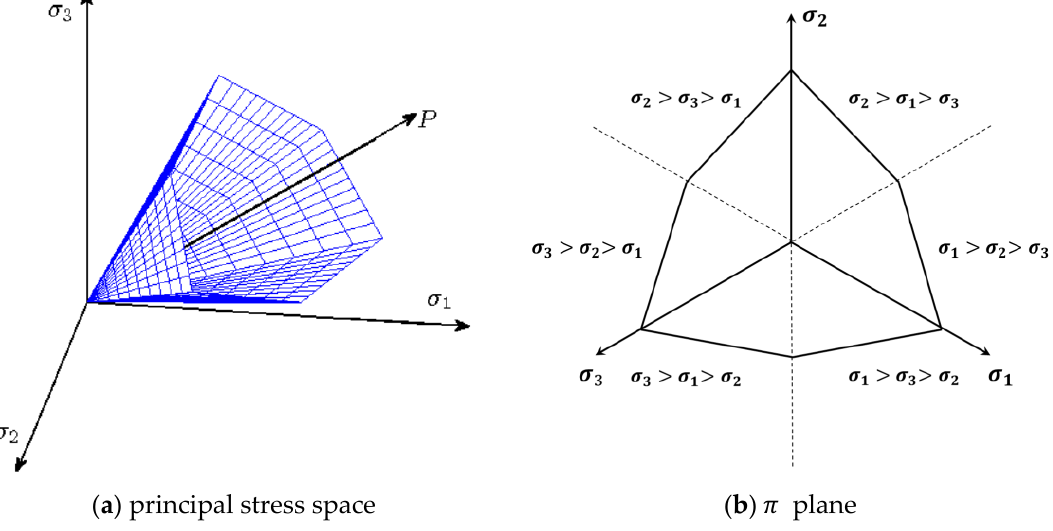
Figure 4. Yield surface of the Mohr-Coulomb soil model in the principal str ess space and π plane. Table 3. Physical property parameters of seabed foundation soil.